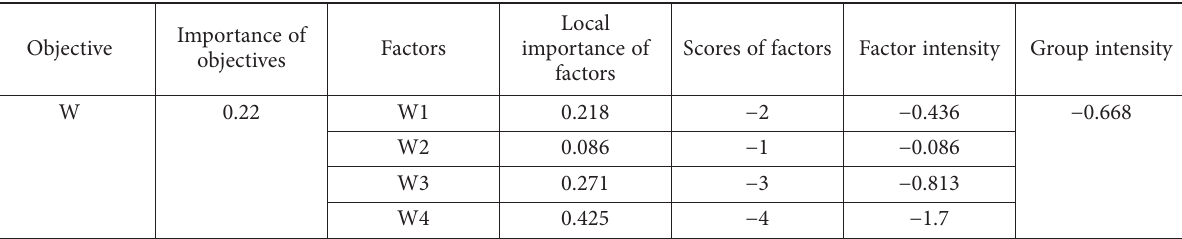
Table A3. Intensity for weakness factors and groupings in SNC (one expert)